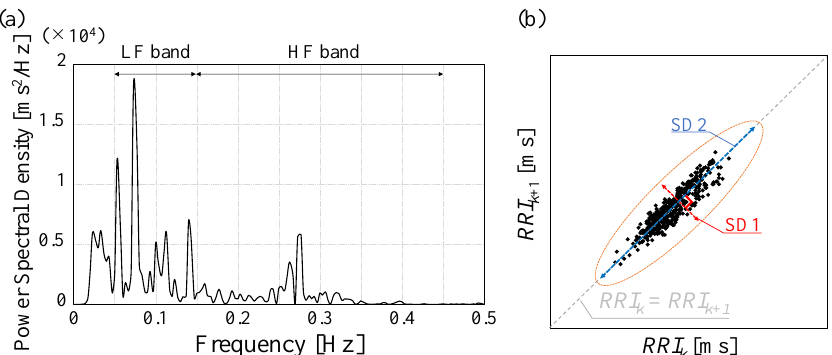
Figure 3. Flow chart of analysis of HRV. LF/HF can be calculated from the energy ratio of LF (from 0.04 Hz to 0.15 Hz) of the time series of RRI to HF (from 0.15 Hz to 0.40 Hz). This parameter was calculated using the power spectrum obtained by FFT treatment. An example of the power spectrum is shown in Figure 4a. SD2/SD1 can be calculated as follows: By using the obtained time series of RRI , a Poincaré plot can be firstly obtained by plotting RRI at k th time step ( RRI k ) on the horizontal axis, while plotting RRI at k + 1 th time step ( RRI k +1 ) on the vertical axis, as shown in Figure 4b. Then, SD2/SD1 can be calculated using the SD1 and SD2 of the Poincaré plot. Note that SD1 and SD2 are standard deviations of the plotted data in the orthogonal short and long axes of the ellipse, as shown in Figure 4b.